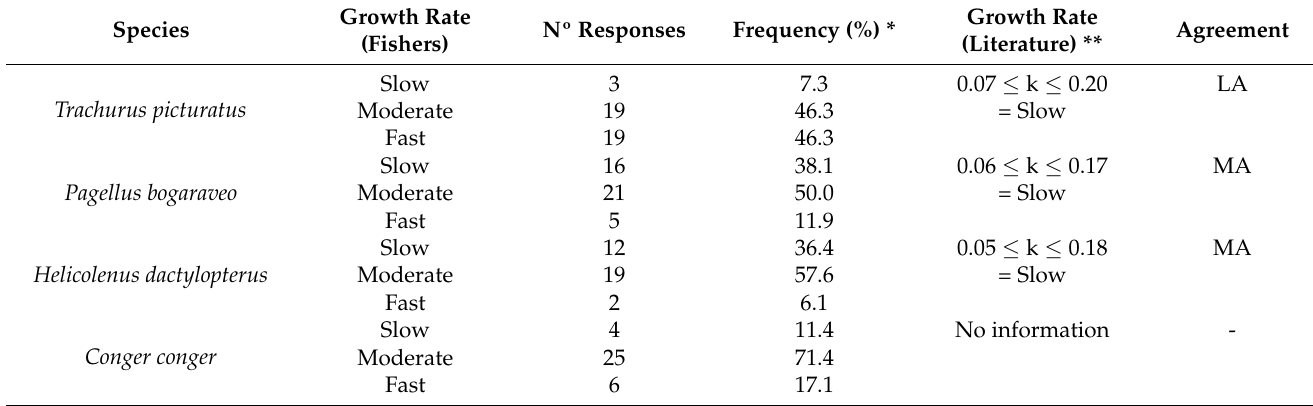
ences were observed between the median values from the different data sources ( P. pagrus :